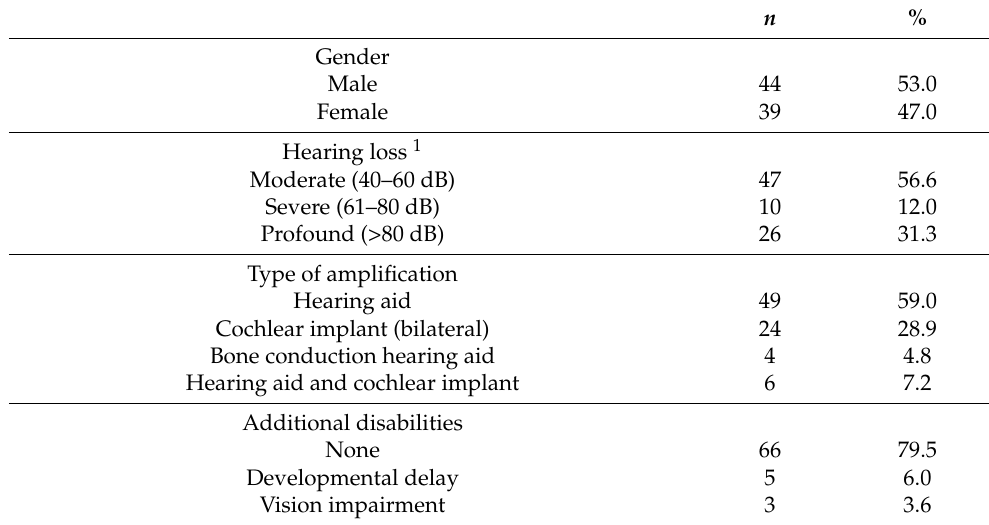
Table 2. Characteristics of the participants and their